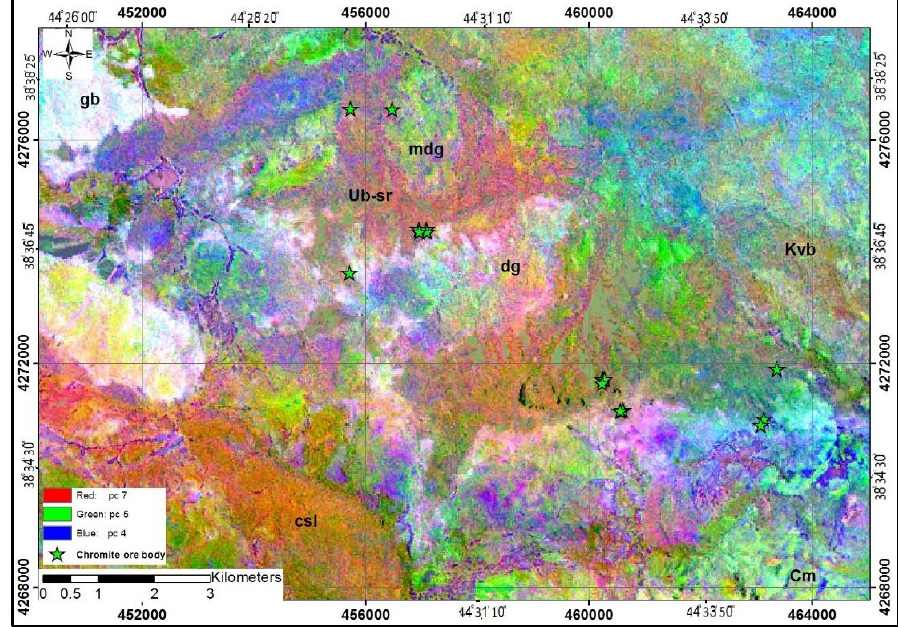
Figure 11. The RGB image of PC7, PC5, and PC4 of PCA bands in the study area.